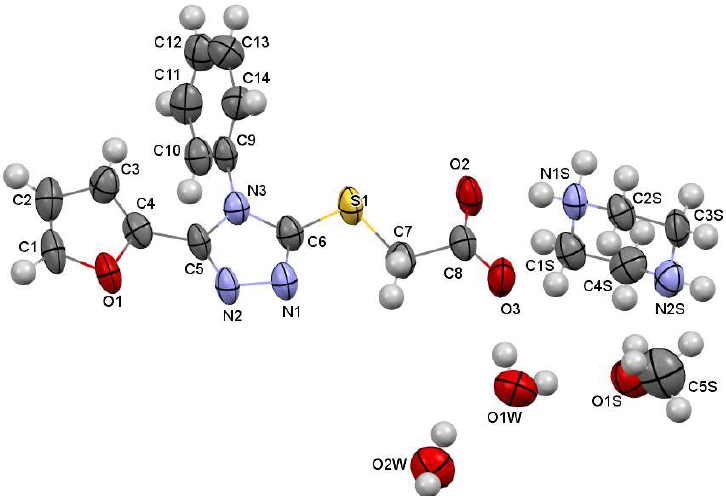
Fig. 2. Molecular structure of the